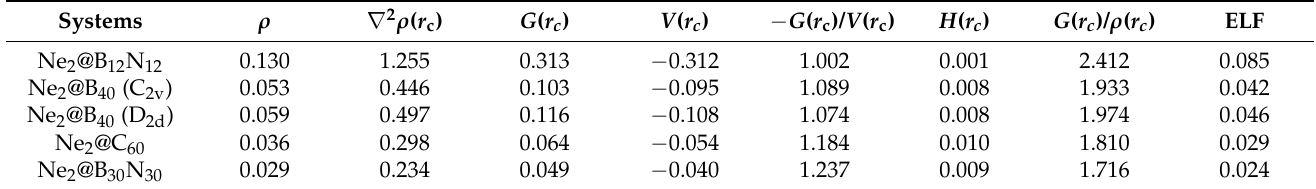
Table 5. Total interaction energy values and components in kcal mol − 1 obtained from EDA results Ne 2 @cage systems using Ne 2 and the cage as the